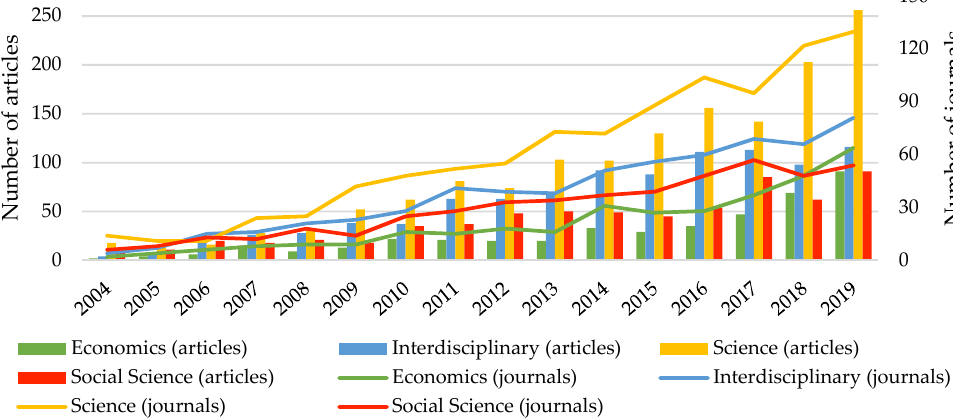
Figure 3. Number of articles by main discipline. Source: Authors; N = 3534.